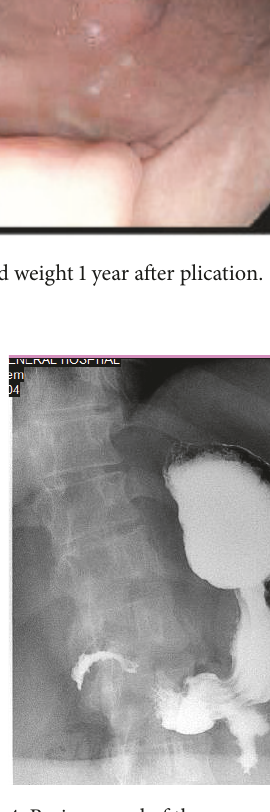
Figure 4: Barium meal of the same patient 4 years after